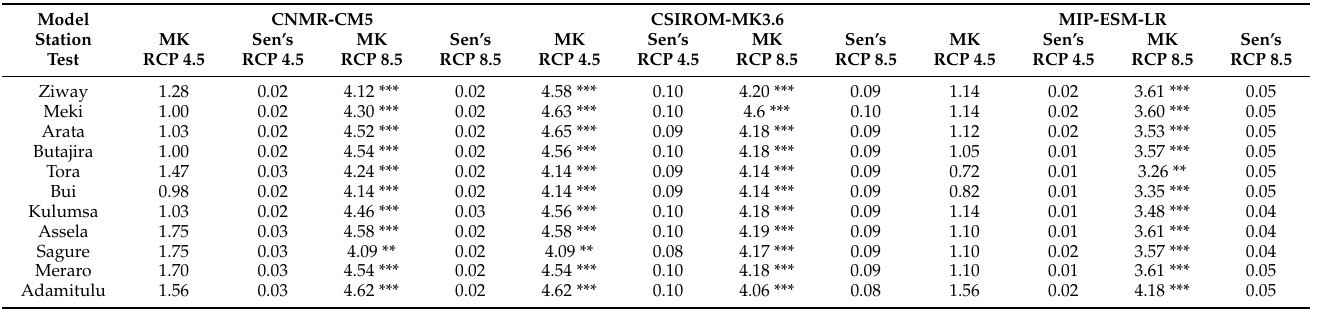
Table A11. Projected Mann–Kendall trend and Sen’s slope estimator results of annual mean T min for 11 stations over Ziway Lake Basin from the period 2050–2072.